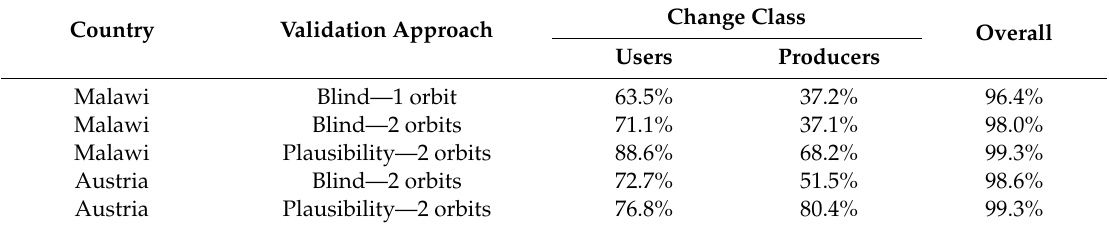
Table 2. Summary of the accuracy measures for the forest change maps at both test sites for di ff erent assessment approaches (blind interpretation and plausibility analysis).